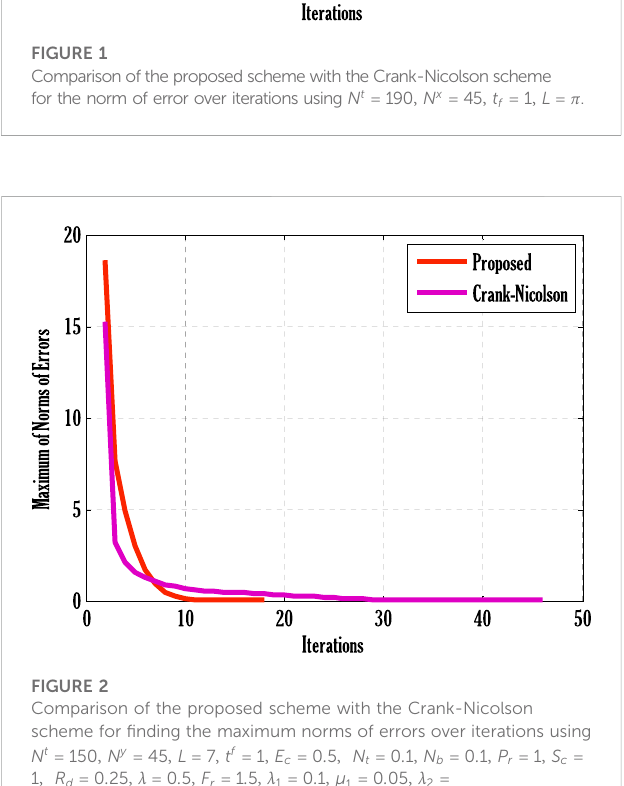
FIGURE 2 Comparison of the proposed scheme with the Crank-Nicolson scheme for fi nding the maximum norms of errors over iterations using N t (cid:2) 150 , N y (cid:2) 45 , L (cid:2) 7 , t f (cid:2) 1 , E c (cid:2) 0 . 5 , N t (cid:2) 0 . 1 , N b (cid:2) 0 . 1 , P r (cid:2) 1 , S c (cid:2) 1 , R d (cid:2) 0 . 25 , λ (cid:2) 0 . 5 , F r (cid:2) 1 . 5 , λ 1 (cid:2) 0 . 1 , μ 1 (cid:2) 0 . 05 , λ 2 (cid:2) 0 . 1 , μ 2 (cid:2) 0 . 1 , γ (cid:2) 0 . 9 , M (cid:2) 0 . 5 , β (cid:2) 3.